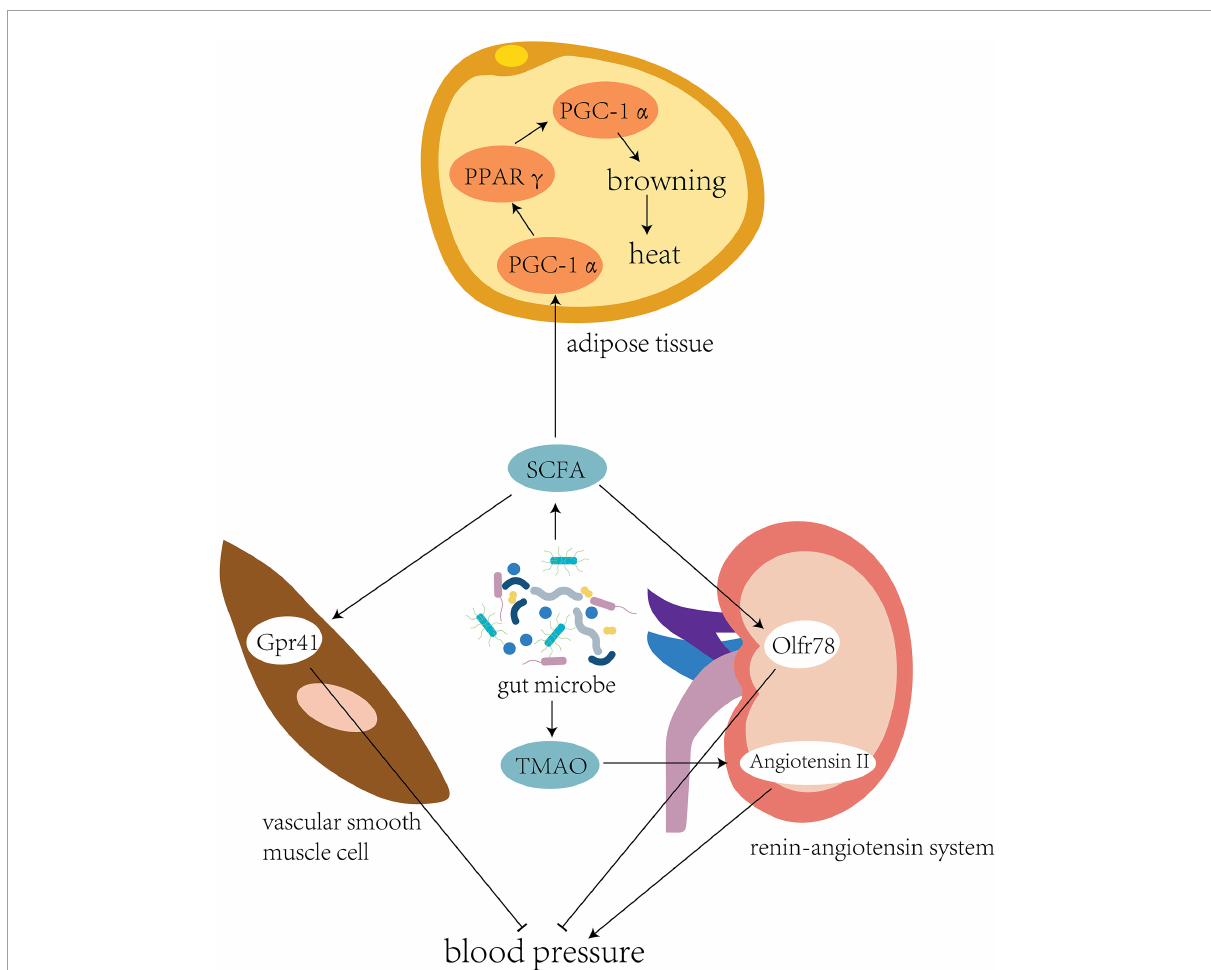
FIGURE2 Intestinal flora regulates blood pressure and energy metabolism. The intestinal flora of individuals living in the plateau environment can produce a large number of short-chain fatty acids to provide energy. This promotes the expression of transcription cofactor PGC-1 α , upregulates the peroxisome proliferator-activated receptor (PPAR γ ), and mediates the coupling protein UCP1, thereby inducing browning of the white fat to generate more heat to adapt to the cold plateau environment. Meanwhile, binding of SCFA to the Gpr41 and Olfr78 receptors could effectively regulate blood pressure in the high-altitude population. Another bacterial product, TMAO, could directly inhibit the pressor effect of angiotensin II to fight against elevated blood pressure caused by high